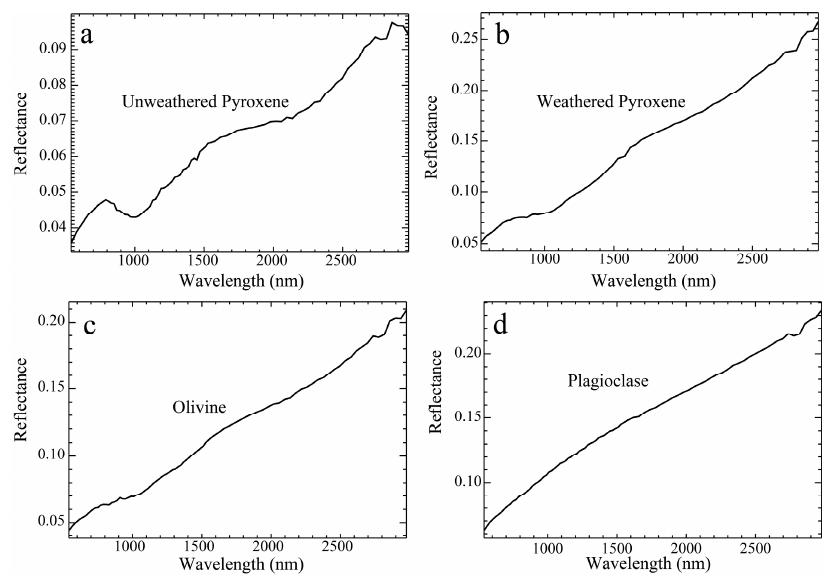
Figure 14. Spectral reflectance curves of the materials in the Orientale Basin: ( a ) unweathered pyroxene-rich materials at Il’in crater wall; ( b ) weathered pyroxene-rich basalt; ( c ) possible olivine rocks in the small and fresh crater wall; ( d ) feldspathic materials on the surrounding